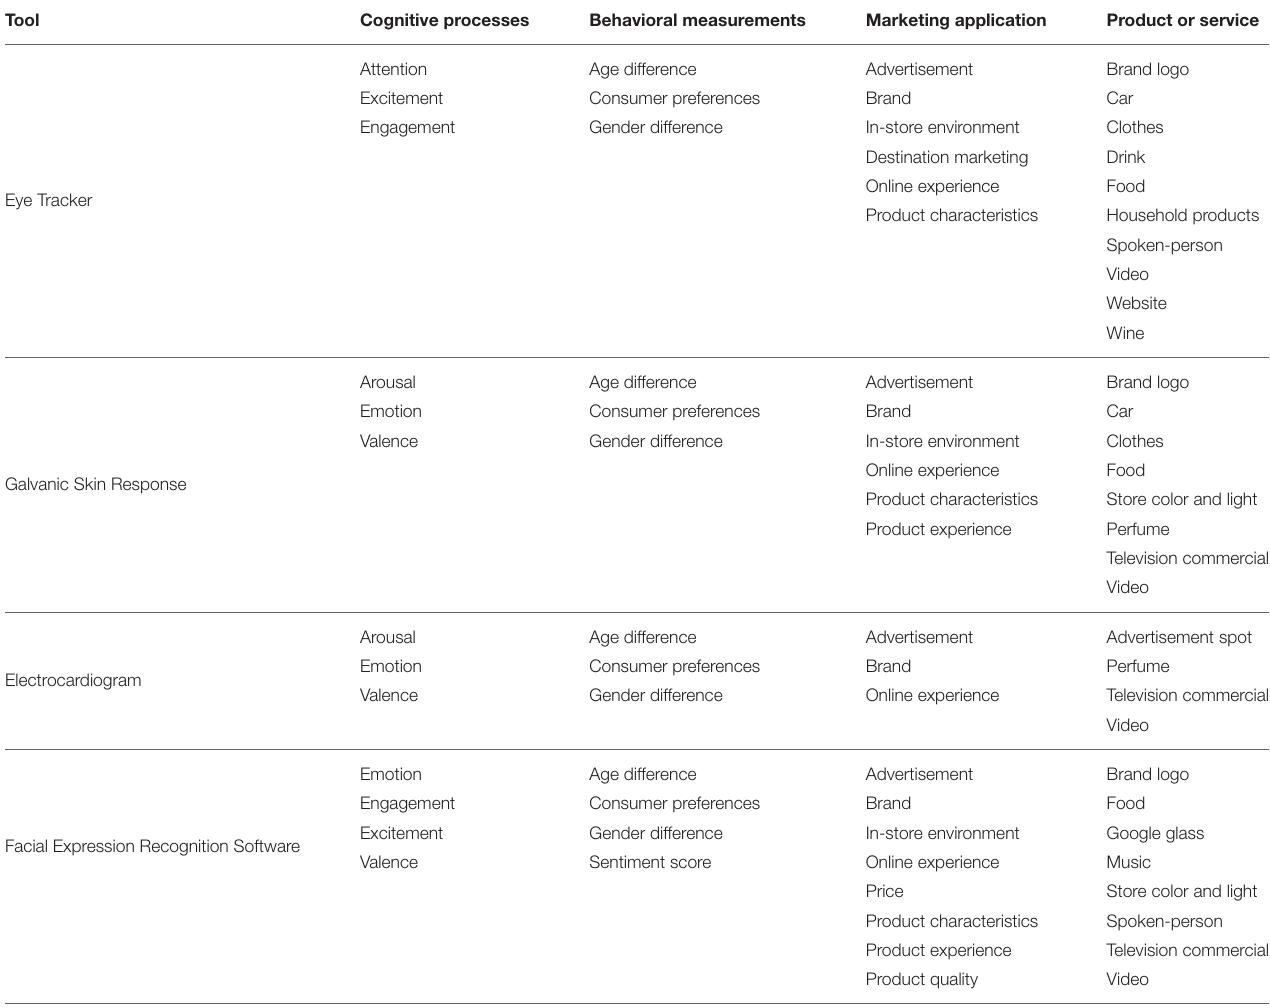
TABLE 4 | Physiological tools: applications in marketing, products and